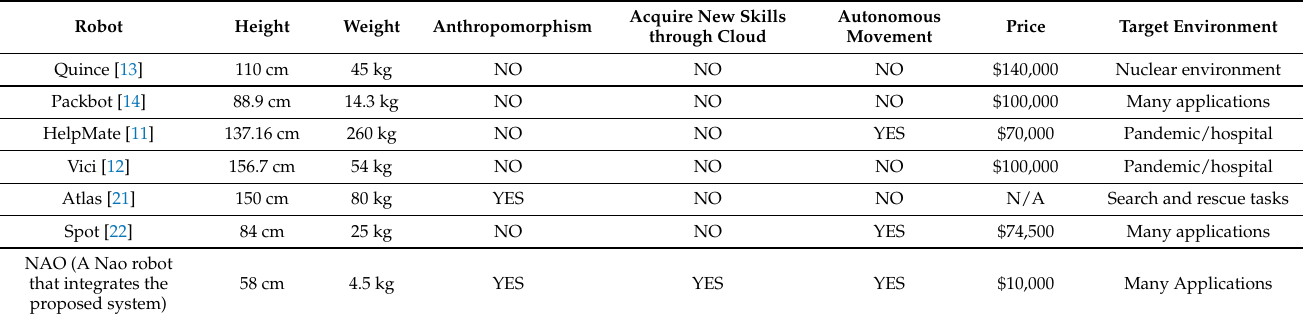
Table 1. A comparison of state-of-the-art robots used in hazardous environments.